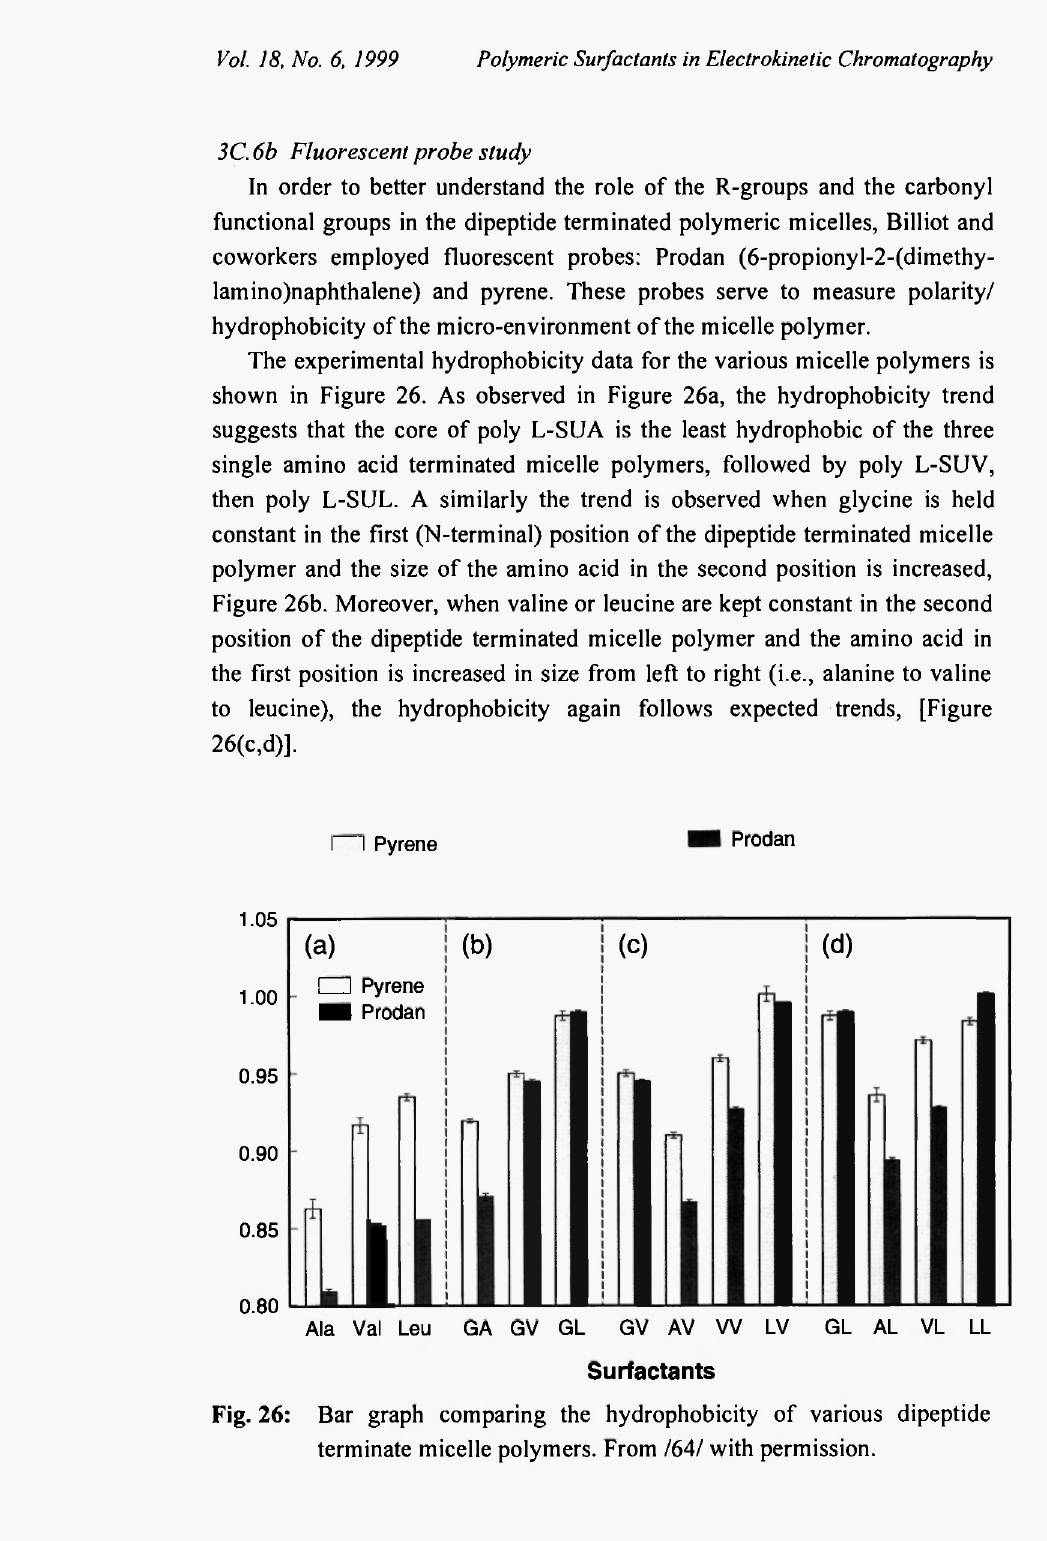
Fig. 26: Bar graph comparing the hydrophobicity of various dipeptide terminate micelle polymers. From /64/ with